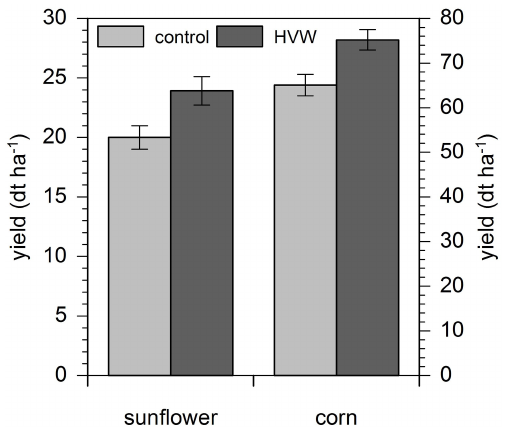
Figure 2. Yields of the main crops sunflower (in Orhei) and corn (in Cahul) on experimental fields after HVW intercropping and on control sites. Error bars represent standard deviation ( n =